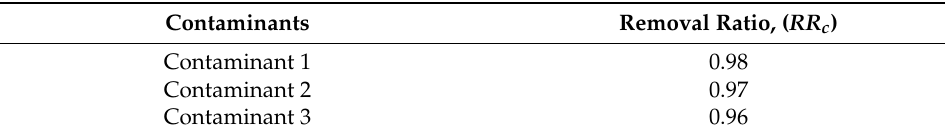
Table A9. Contaminant removal ratio for case study 3 [11].